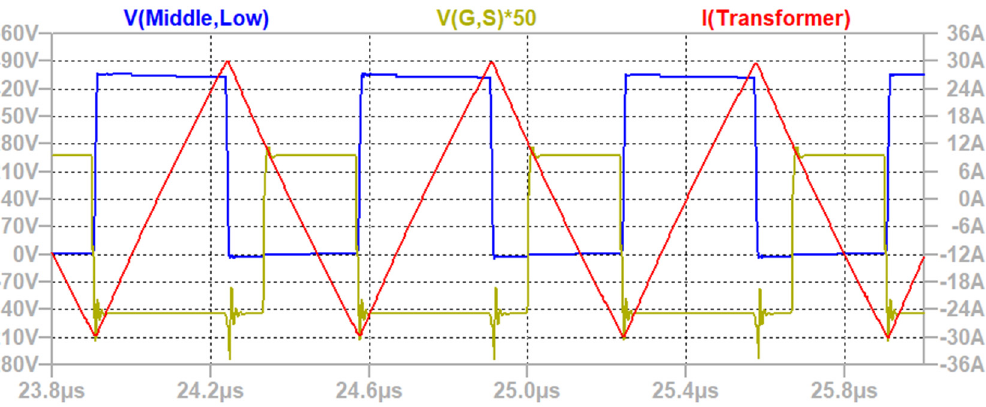
Figure 6. Simulation results of the test bench; in red the current; in blue Vds; and in yellow Vgs. and soft-switching operations. The 15.61 arms (red) for a square voltage signal of 450 V were obtained (yellow). The Vgs signal (blue) shows the soft-switching mode when the simultaneous current is changing of signs.